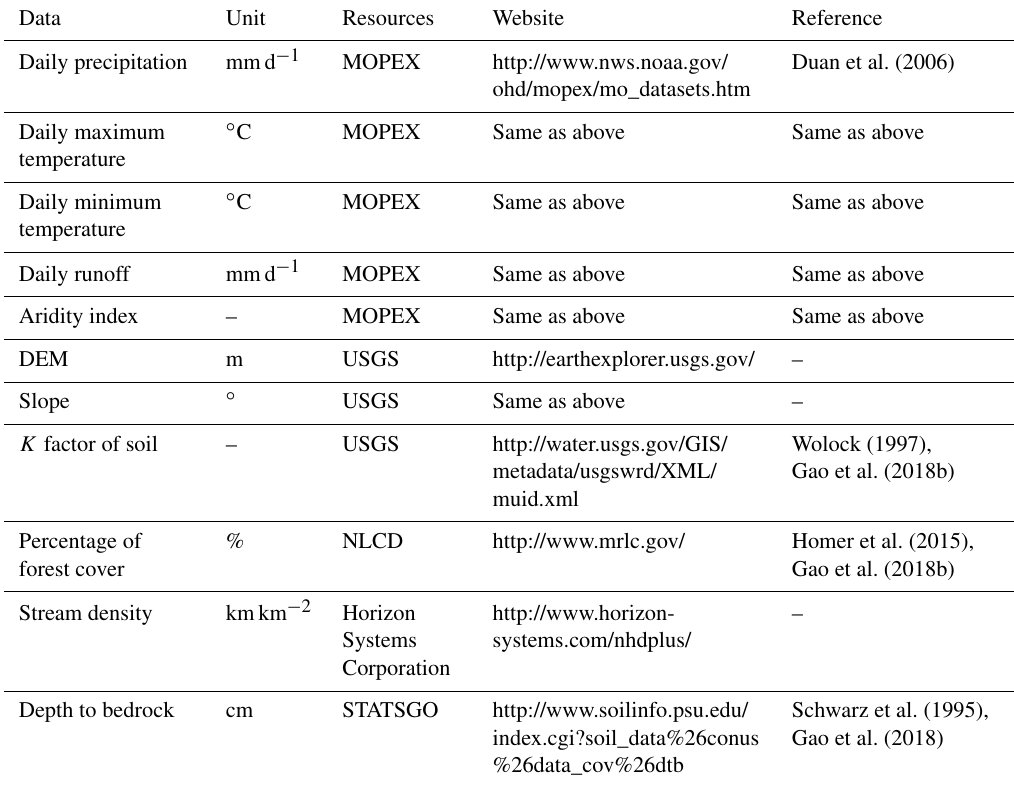
Table 3. Data source of the MOPEX catchments. All links in this table were last accessed on 6 February 2017. Data Unit Resources Website Reference Daily